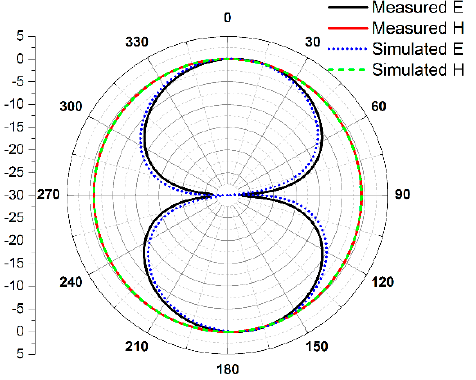
Figure 14. Measured and simulated radiation pattern for switches 2 and 4 ON, switches 3 and 5 OFF. Table 5. Summarized results of Case 3.